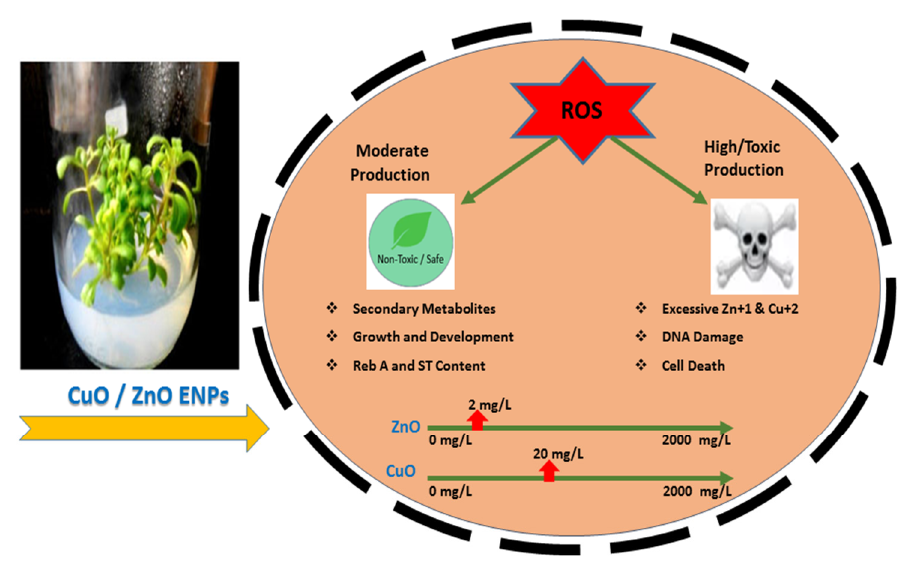
Figure 6. Mechanism illustrating the action of different dosages of ZnO and CuO ENPs for the induction of abiotic stress and stimulation of morphophysiological and biochemical responses in tissue culture regenerants of the Candyleaf due to the production of reactive oxygen species (ROS) in its cellular compartments.